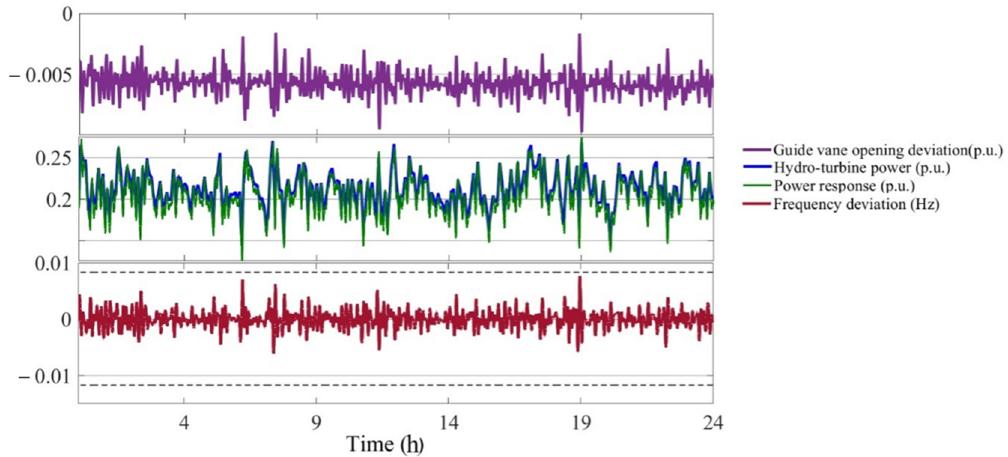
Figure 8. Complementary results of the wind-hydro hybrid power system in the time scale of hours (24 h in total). The dotted lines for the frequency deviation denote the accepted values, i.e., ±0.2 Hz. The power response is equal to the difference between the load demand and the actual output of wind power. The “p.u.” is short for the unit of guide vane opening, hydro-turbine power and power response, the “Hz” is short for the unit of frequency deviation, and the “h” is short for the time unit.